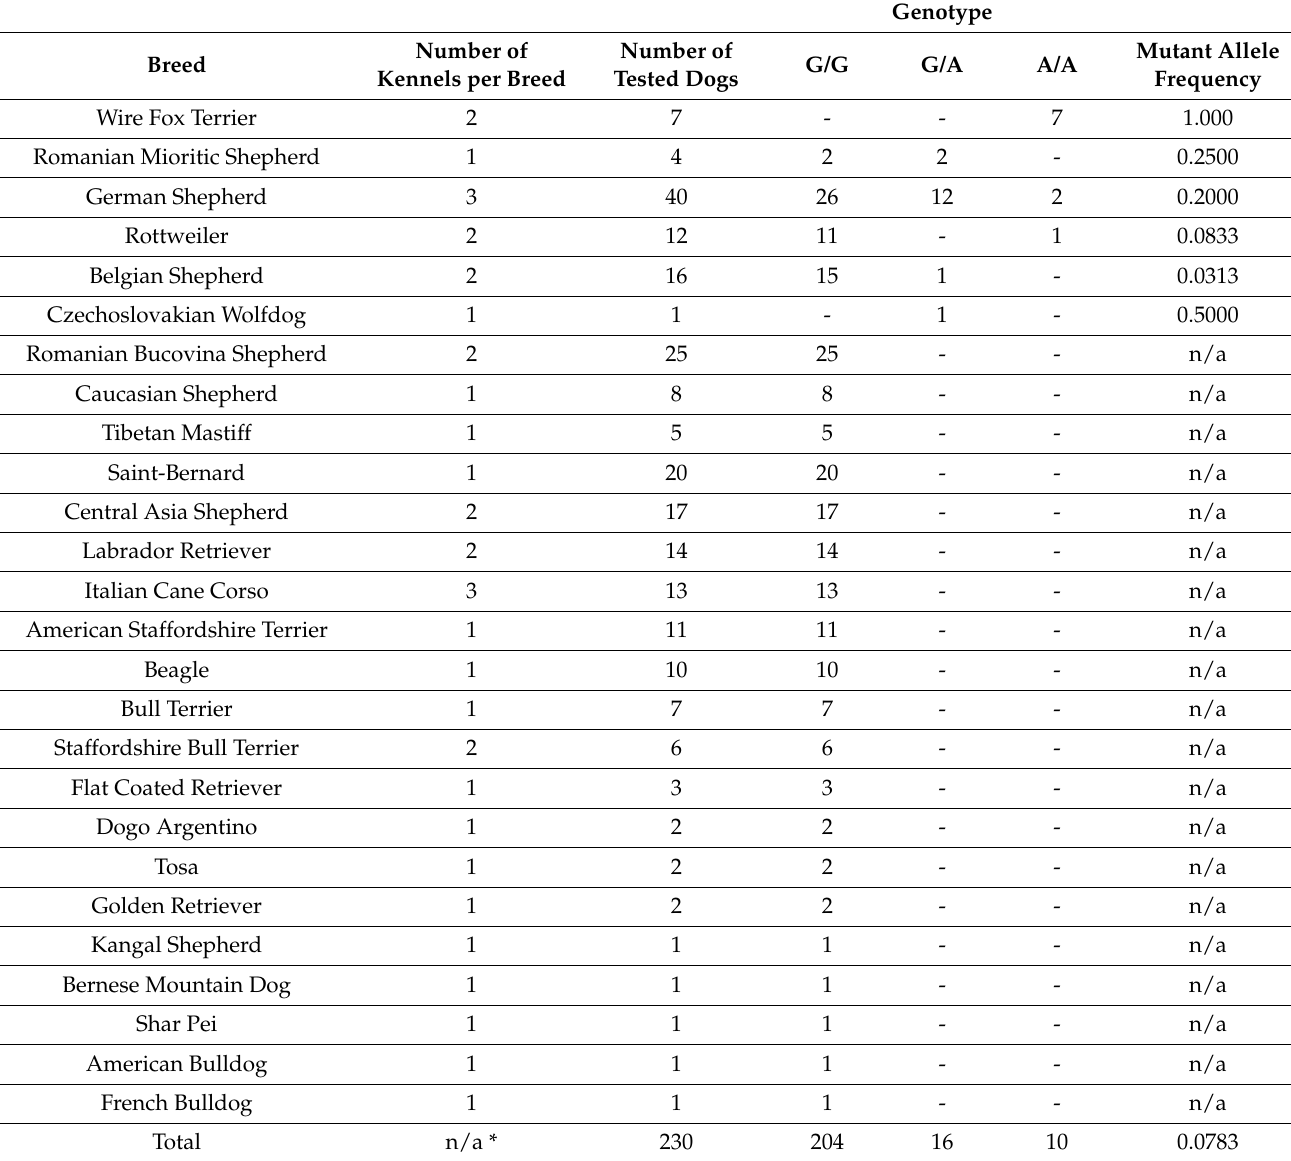
Table 1. Genotype distribution among dog